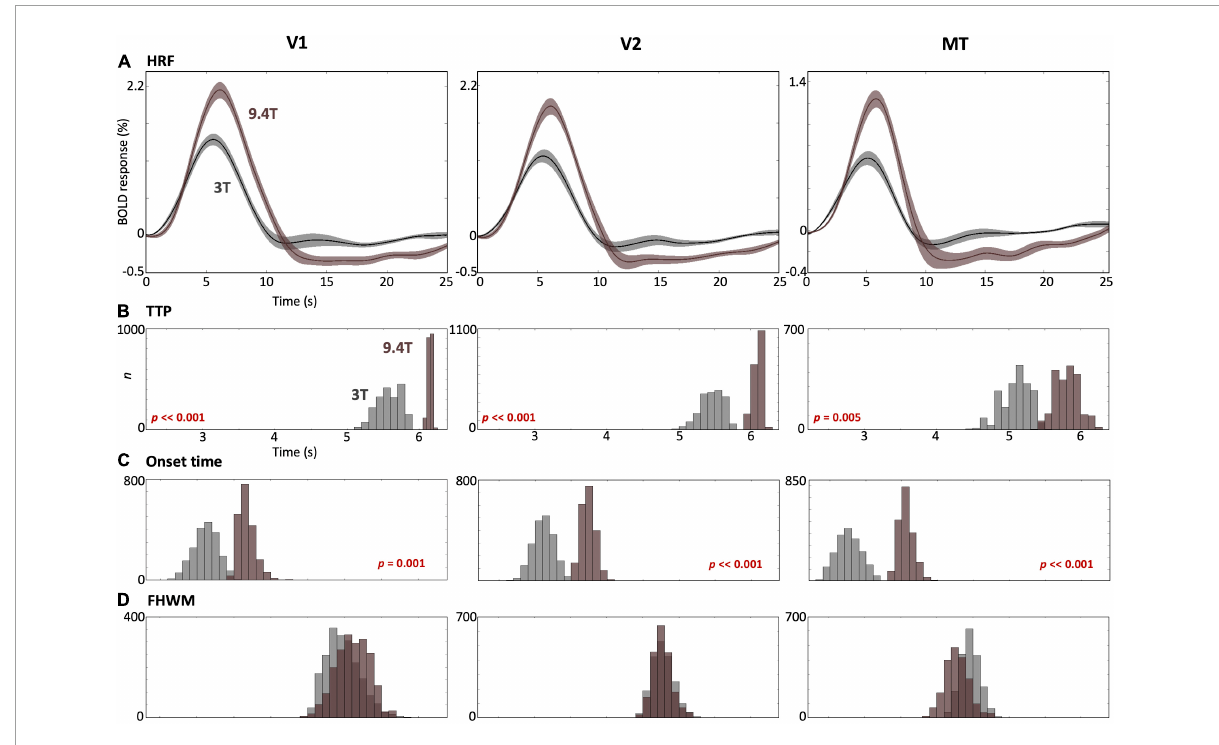
FIGURE6 (A) Comparison of the mean HRF (solid) with 68% confidence intervals (shaded region) across subjects in V1 (left), V2 (middle) and MT (right) between 3T (gray) and 9.4T (brown). (B–D) Bootstrapped histograms below show HRF temporal parameters for both field strengths with p -values for significant differences.